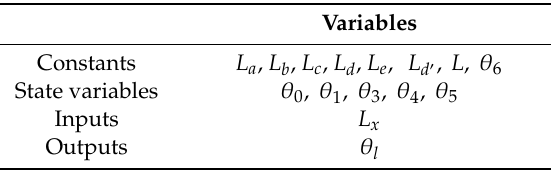
Table 2. Variables of the VGV mechanistic model.